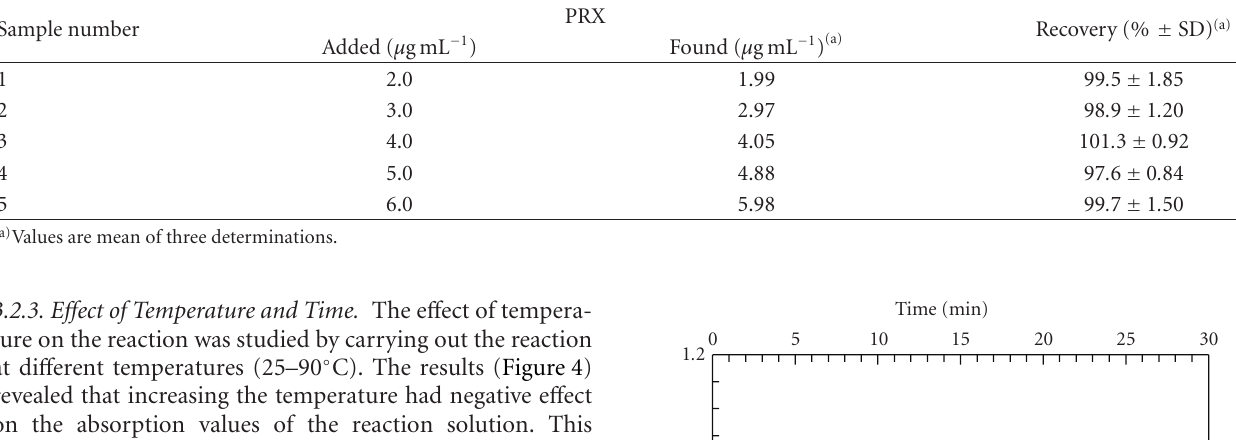
Table 2: Recovery studies for determination of PRX by the proposed method.